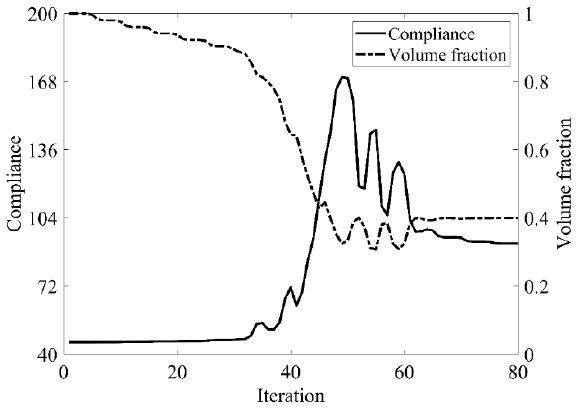
Figure 26. Convergence history of the compliance and the volume fraction for cantilever beam by CBT level set topology optimization.